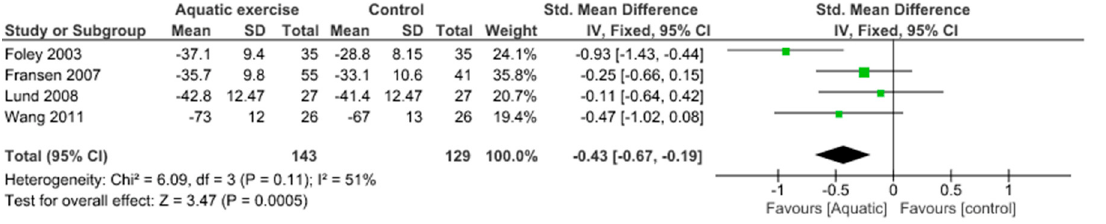
Figure 13. Quality of Life: Aquatic exercise versus